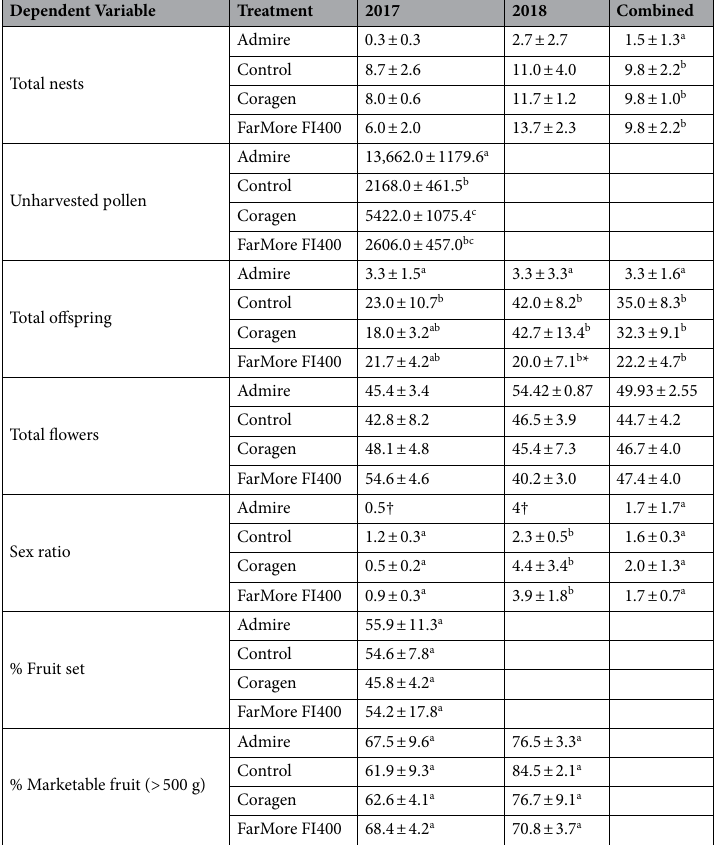
on squash bee behaviour or might be a result of the application method (foliar spray or seed coating) reducing the extent of exposure to the active ingredient in soil, nectar, and/or pollen. For Coragen, the lack of measurable effects could be because only a single application was made for cutworm control 47 after which bees were not yet active during the period of residual activity (reported to be 21 days after application: https ://ag.fmc.com/us/ en/insec ticid es-mitic ides/corag en-insec ticid e). Exposure to a chlorantraniliprole-treated crop may have had greater impact if the chlorantraniliprole spray had been applied closer to the bee active period. It should be noted, however, that residues of imidacloprid, thiamethoxam (and its metabolite clothianidin), and chlorantraniliprole were detected in some of the soil samples taken during the bee active period in both 2017 and 2018 (Table S6). The results for imidacloprid (Admire applied to the soil at seed planting) are consistent with studies indicat- ing neonicotinoid-exposure can reduce nesting activity in stem-nesting solitary bees 37,42 and delay or reduce the likelihood of nest establishment in bumblebees 33,34,48,49 . Our study is the first to report an impact of neonicoti- noid-exposure on nesting in any solitary ground-nesting species, arguably the most ecologically important and biodiverse group of bees. The 85% reduction in nest establishment (over 2 years) by squash bee females exposed to a squash crop treated with soil-applied imidacloprid under real agricultural conditions incorporates both contact with soil and consumption of contaminated nectar and pollen as potential routes of exposure, whilst previous studies have focused solely on oral exposure 32–34,37,42,48,49 . During their nesting phase, hoary squash bees also amass pollen to provision their nest cells. The reproduc- tive success of female solitary bees is limited by the number of nest cells they can provision 42,44 , and the amount of pollen harvested affects the subsequent reproductive success of their offspring 50–52 . To determine if exposure to crops treated with systemic insecticides affected pollen harvesting by female hoary squash bees, we counted the pollen remaining on anthers of squash flowers at the end of the daily foraging period in each hoop house (Methods; Figure S1). Pollen collection was substantially affected by insecticide treatment (F 3,114 = 37.82; p < 0.001; Table S1; Table S2) with 5.3 times more unharvested pollen remaining on anthers in the Admire-treatment than the control (Admire: 13,662.0 ± 1179.6; Control: 2168.0 ± 461.5; t 114 = 9.38, p < 0.001; Fig. 2; Table S3). Although hoary squash bees in the Coragen treatment also collected significantly less pollen than bees in the control group